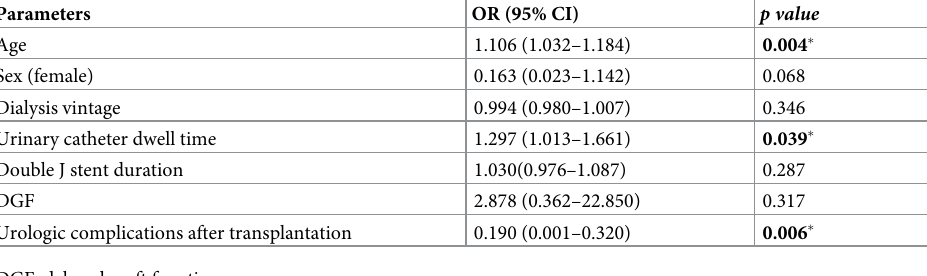
Table 2. Independent risk factors for urinary tract infections in the first year after transplantation.